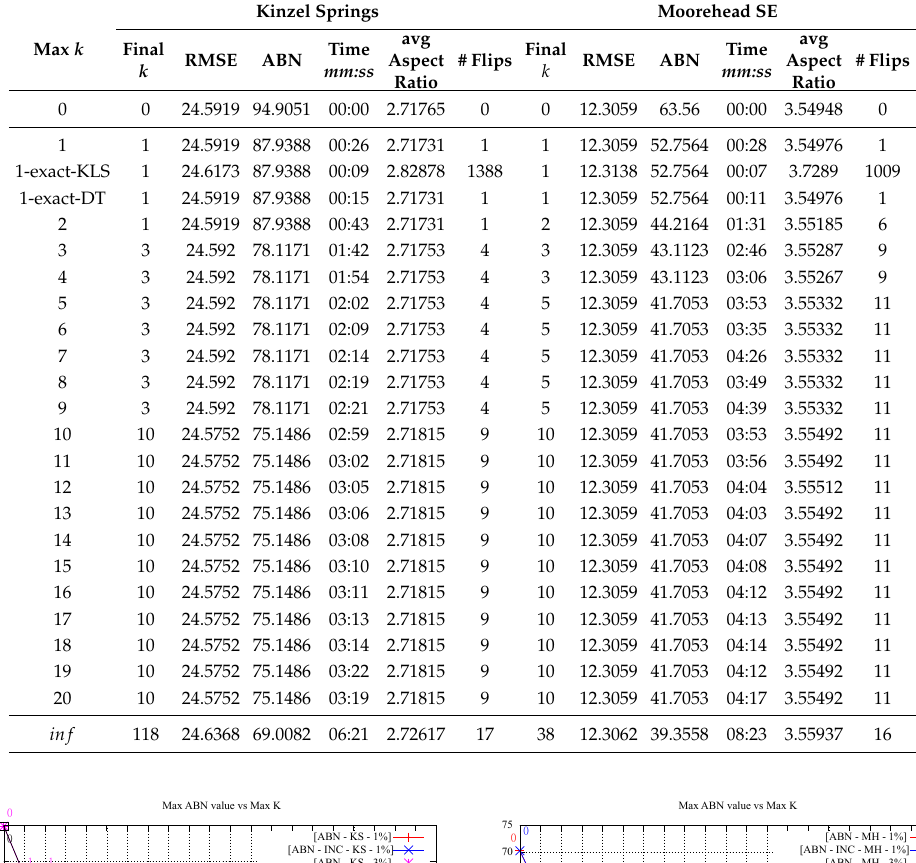
Table 1. Minimization of maximum ABN value for Kinzel Springs and Moorehead SE, over 3% sample point set using LOP—0, 1-exact—KLS and 1-exact-DT.